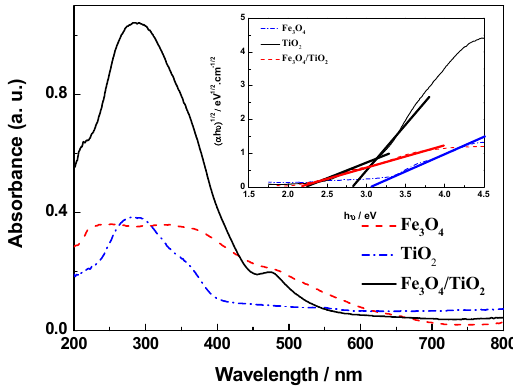
Figure 4. UV-vis diffusion reflection spectra and plots of ( α h ν ) 1/2 versus the photon energy ( h ν ) curves (inset) of Fe 3 O 4 magnetic powder, TiO 2 , and Fe 3 O 4 /TiO 2 nanocomposite.